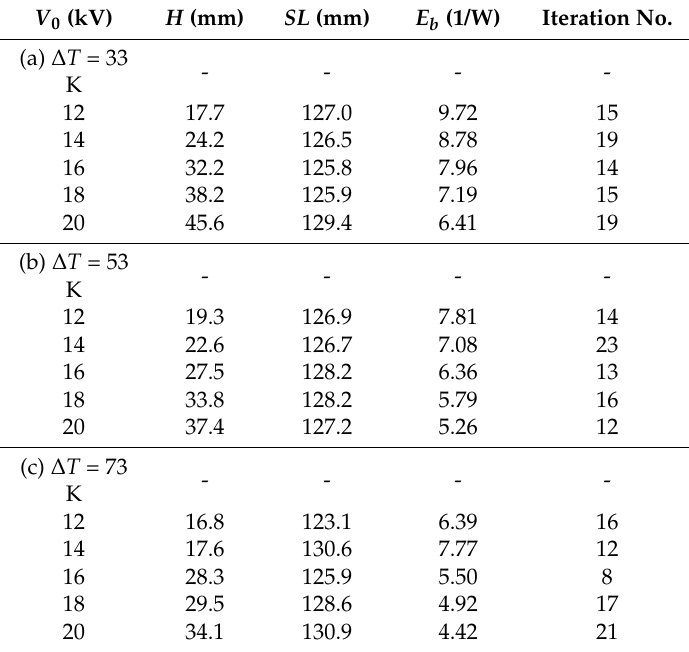
Table 2. The searched optimum combination of H and SL for different applied voltages V 0 and temperature differences ∆ T